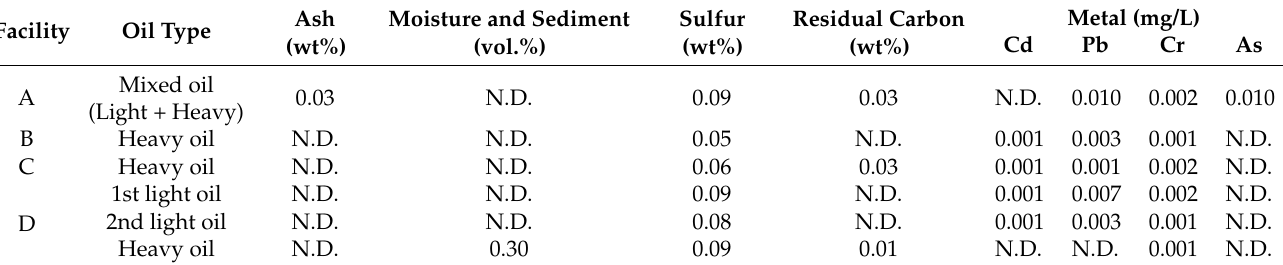
Table 3. Characteristics of pyrolysis oil